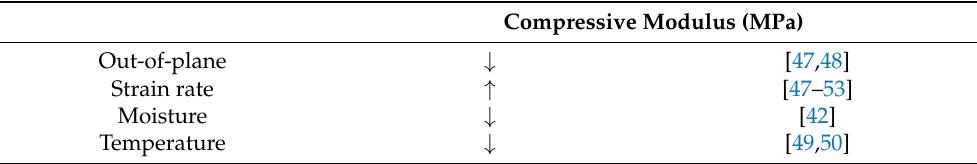
Table 6. Effect of an increase in the test parameters under consideration on the compressive stiffness of agglomerated